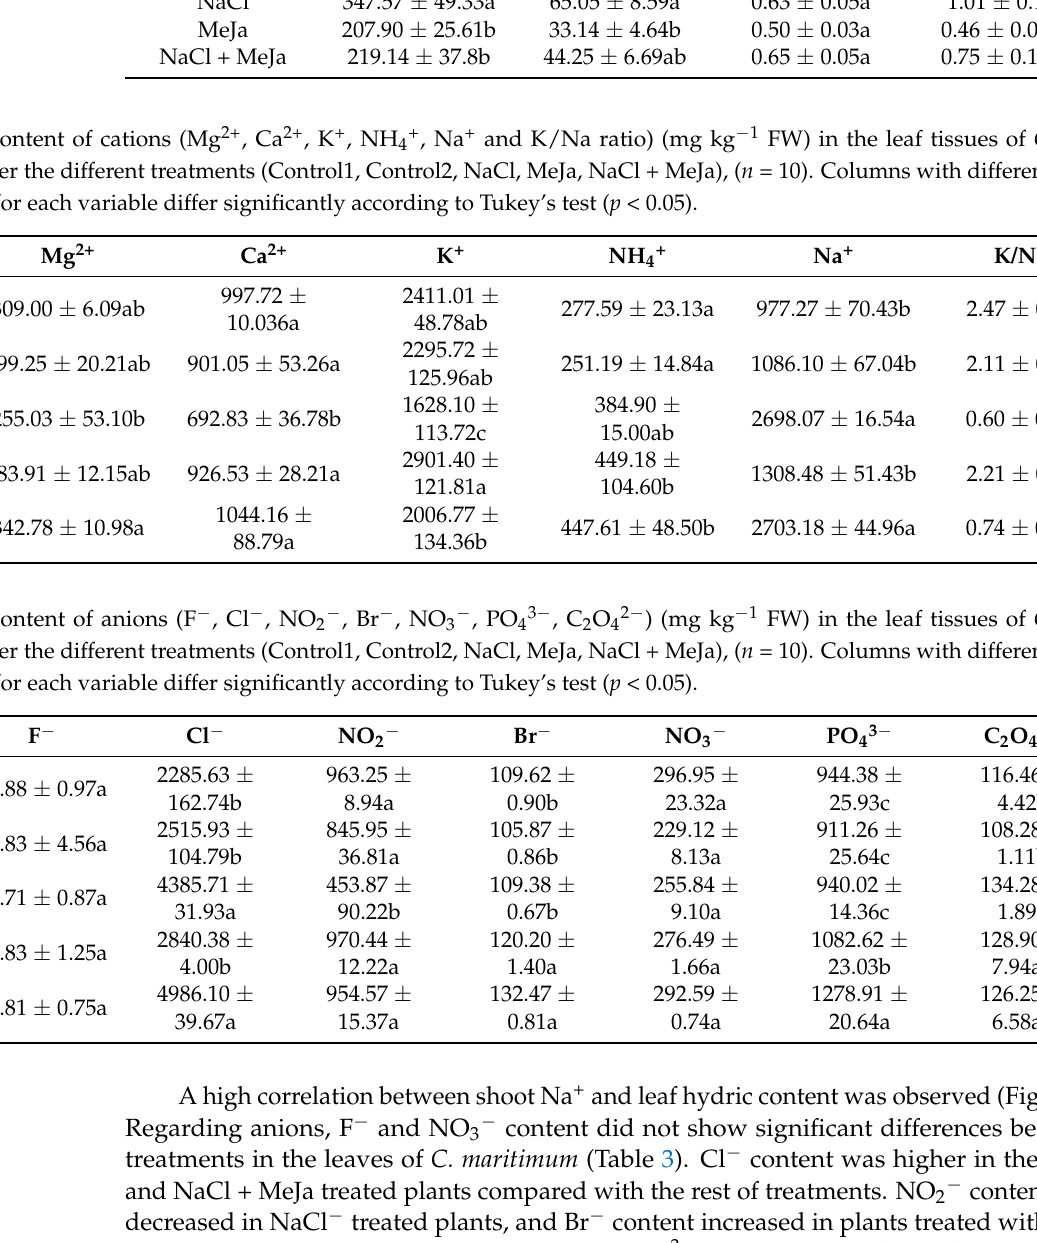
A high correlation between shoot Na + and leaf hydric content was observed (Figure 2). Regarding anions, F − and NO 3 − content did not show significant differences between treatments in the leaves of C. maritimum (Table 3). Cl − content was higher in the NaCl and NaCl + MeJa treated plants compared with the rest of treatments. NO 2 − content only decreased in NaCl − treated plants, and Br − content increased in plants treated with both MeJa treatments in comparison to the rest. PO 4 3 − content was enhanced in MeJa and NaCl + MeJa treated plants, with the increase observed as being higher in plants treated with NaCl + MeJa. Finally, C 2 O 42 − content was higher in NaCl treatment and similar in both control